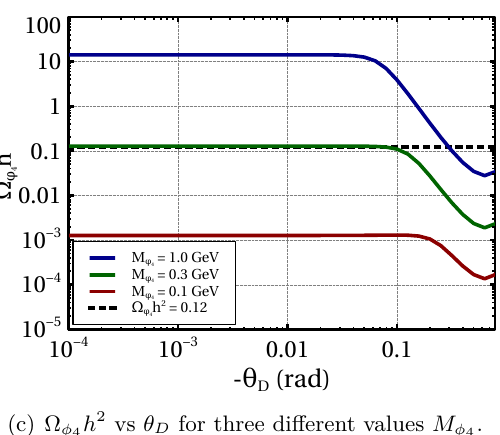
(a) Variation of Ω φ h 2 with ξ for three different val- 4 ues of M φ . 4